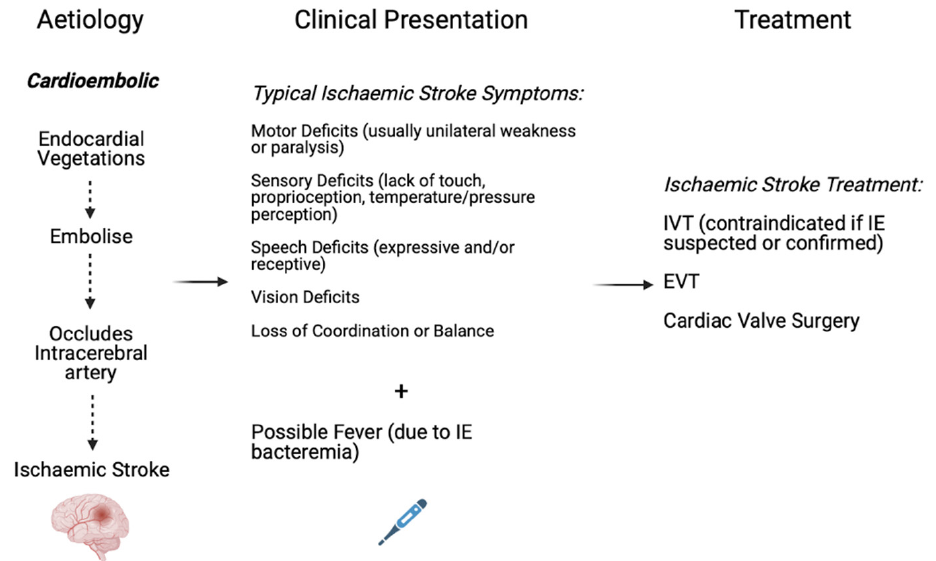
Figure 2. Aetiology, presentation, and treatment of acute ischaemic stroke secondary to infective endocarditis. Abbreviations: IE; Infective endocarditis; IVT: Intravenous thrombolysis; EVT: Endovascular thrombectomy.